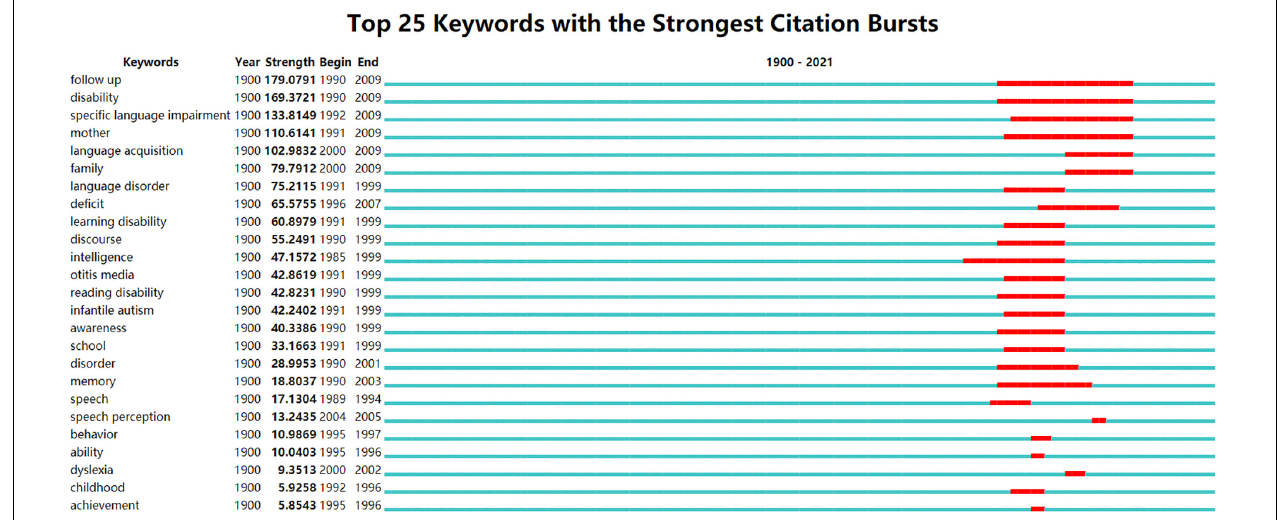
FIGURE 10 | Twenty-five keywords with the strongest citation